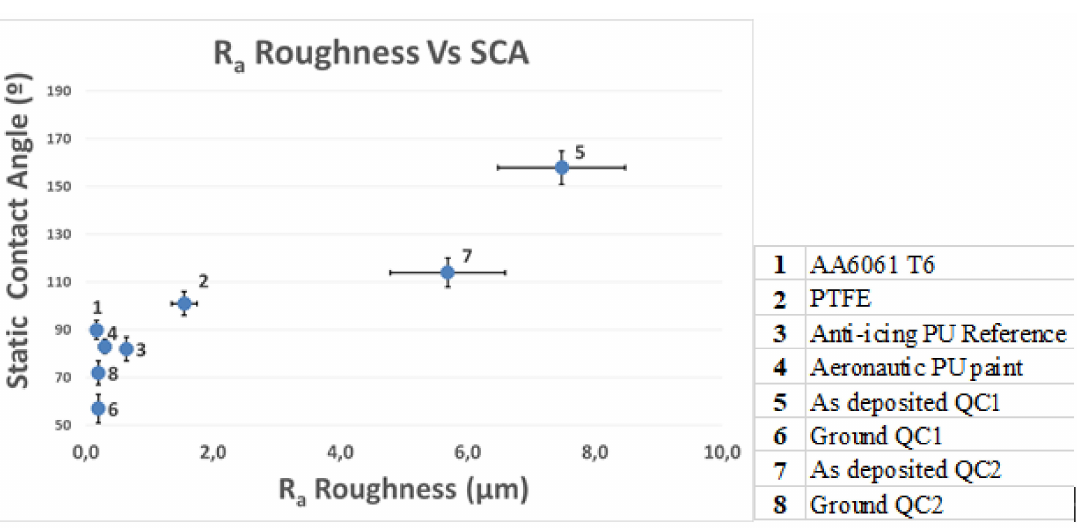
Figure 13. SCA vs Ra roughness for the studied materials and coatings.